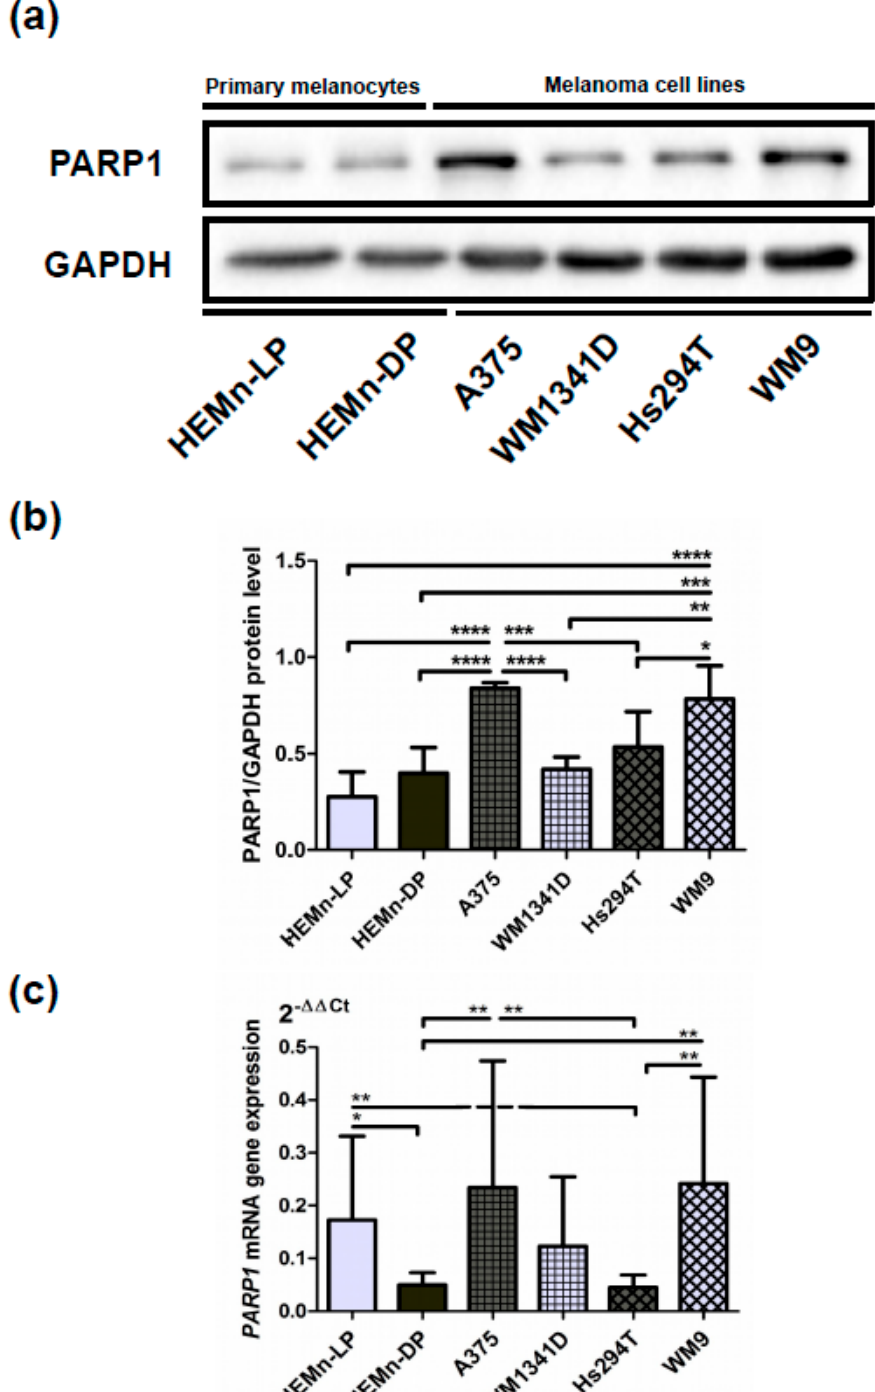
Figure 2. Expression of PARP1 at protein and gene PARP1 mRNA levels. Representative immunoblots showing PARP1 and GAPDH levels in cellular extracts of primary normal melanocytes (HEMn-LP and HEMn-DP) and melanoma cell lines derived from the primary tumor (A375 and WM1341D) and lymph node metastases (Hs294T and WM9) are presented ( a ). Results of densitometric analysis of the PARP1 level (adjusted to GAPDH) are shown as a mean (N = 3) ± SD ( b ). PARP1 gene expression analysis at the mRNA level was performed using real-time PCR in the examined cells in triplicate. Results are expressed as a mean (relative gene expression compared to three housekeeping genes— POLR2A, PPIA, G3PDH ) (N = 3) ± SD of three independent experiments ( c ). The significance level was set at p = 0.05–0.01 (*), p = 0.01–0.001 (**), p = 0.001–0.0001 (***), p ≤ 0.0001